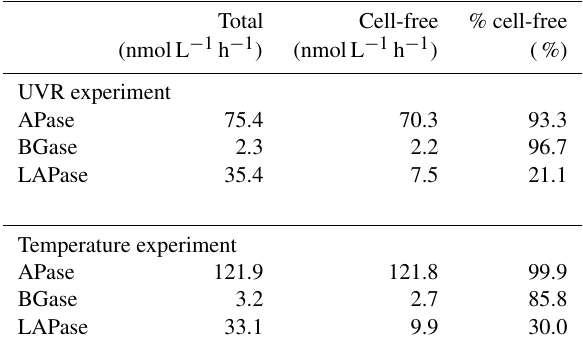
Table 1. Total, cell-free, and proportion of cell-free relative to to- tal extracellular enzymatic activity (EEA) in situ for the seawater collected for the UVR and temperature experiments at the time of